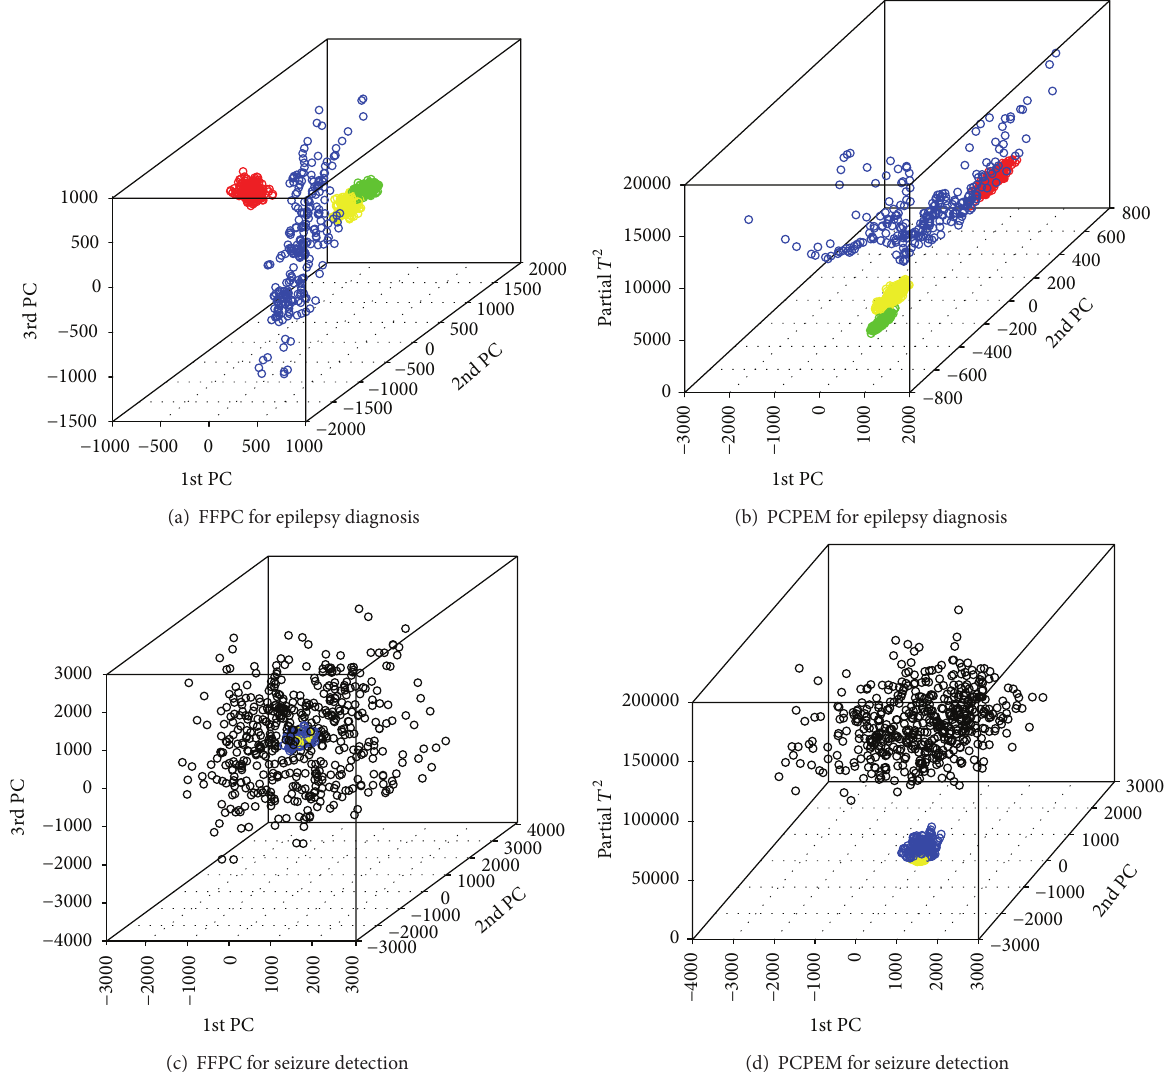
Figure 6: Three-dimensional features scatter plot obtained from the DPCA method for the test signals in Sets A, B, C, D and E for the FFPC method and for PCPEM method in both epilepsy diagnosis (using signals from Sets A, B, C and D) and seizure detection (using signals from Sets C, D and E). The scatter plots in green, red, yellow, blue and black colors stands for signals in Sets A, B, C and D and E,